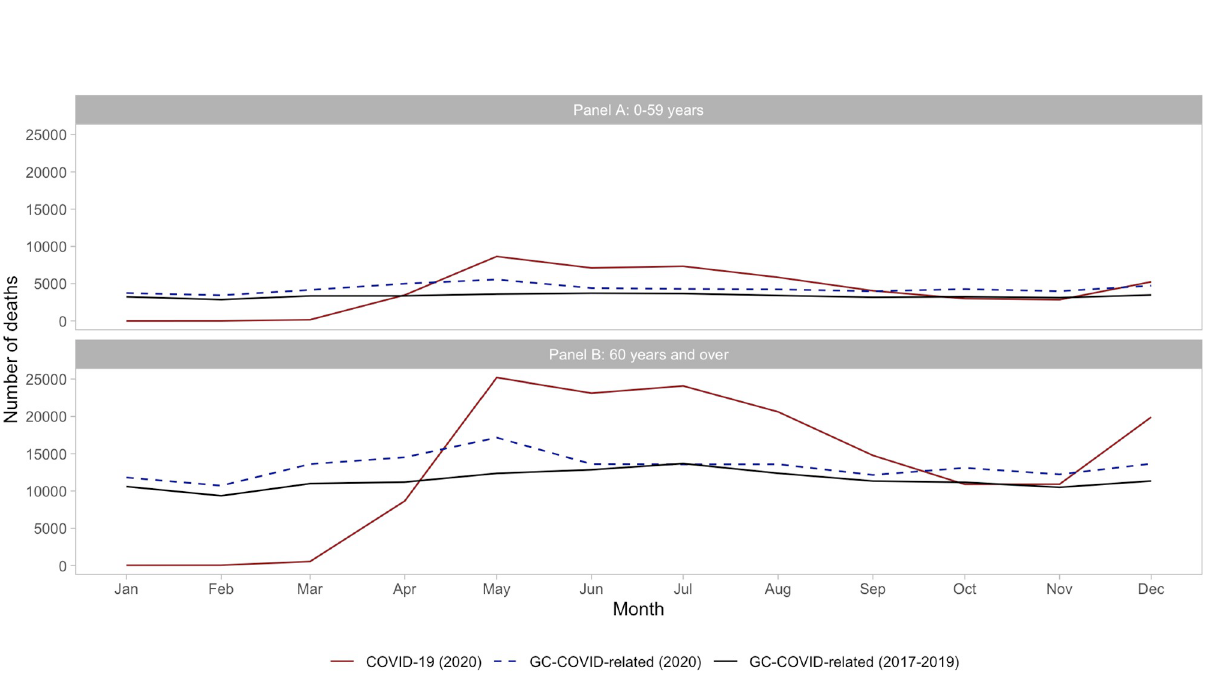
Fig 2. Number of COVID-19 and GC-COVID-related deaths in 2020 compared to the average number of GC-COVID-related deaths in 2017– 2019, by months, among age-groups 0–59 years (Panel A) and 60 years and over (Panel B) in Brazil.